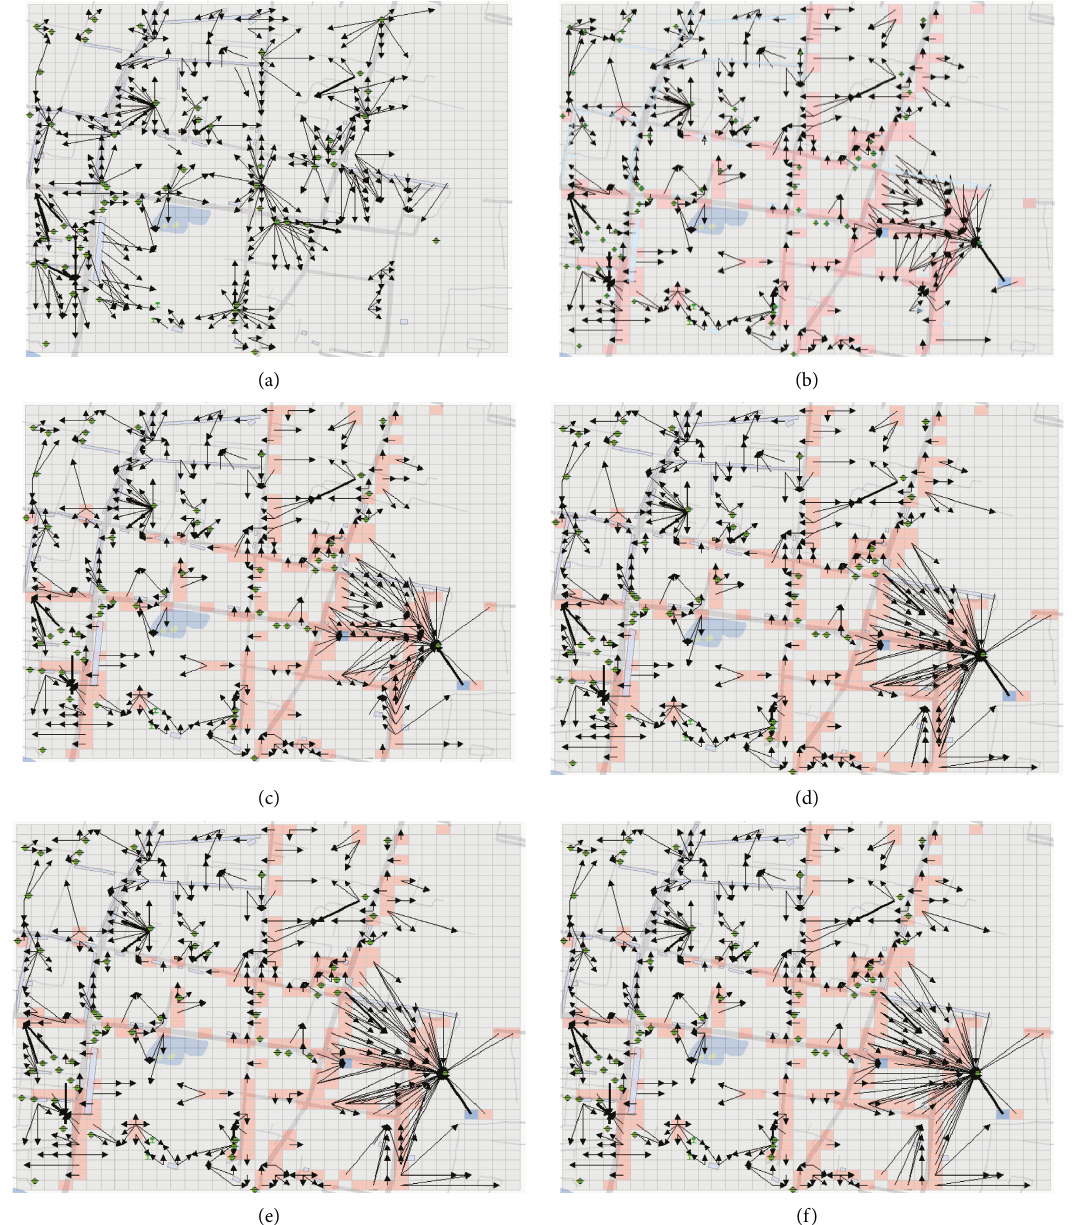
Figure 7: The optimal solutions under different maximal walking distance thresholds. (a) Assignment with existing parking resources.